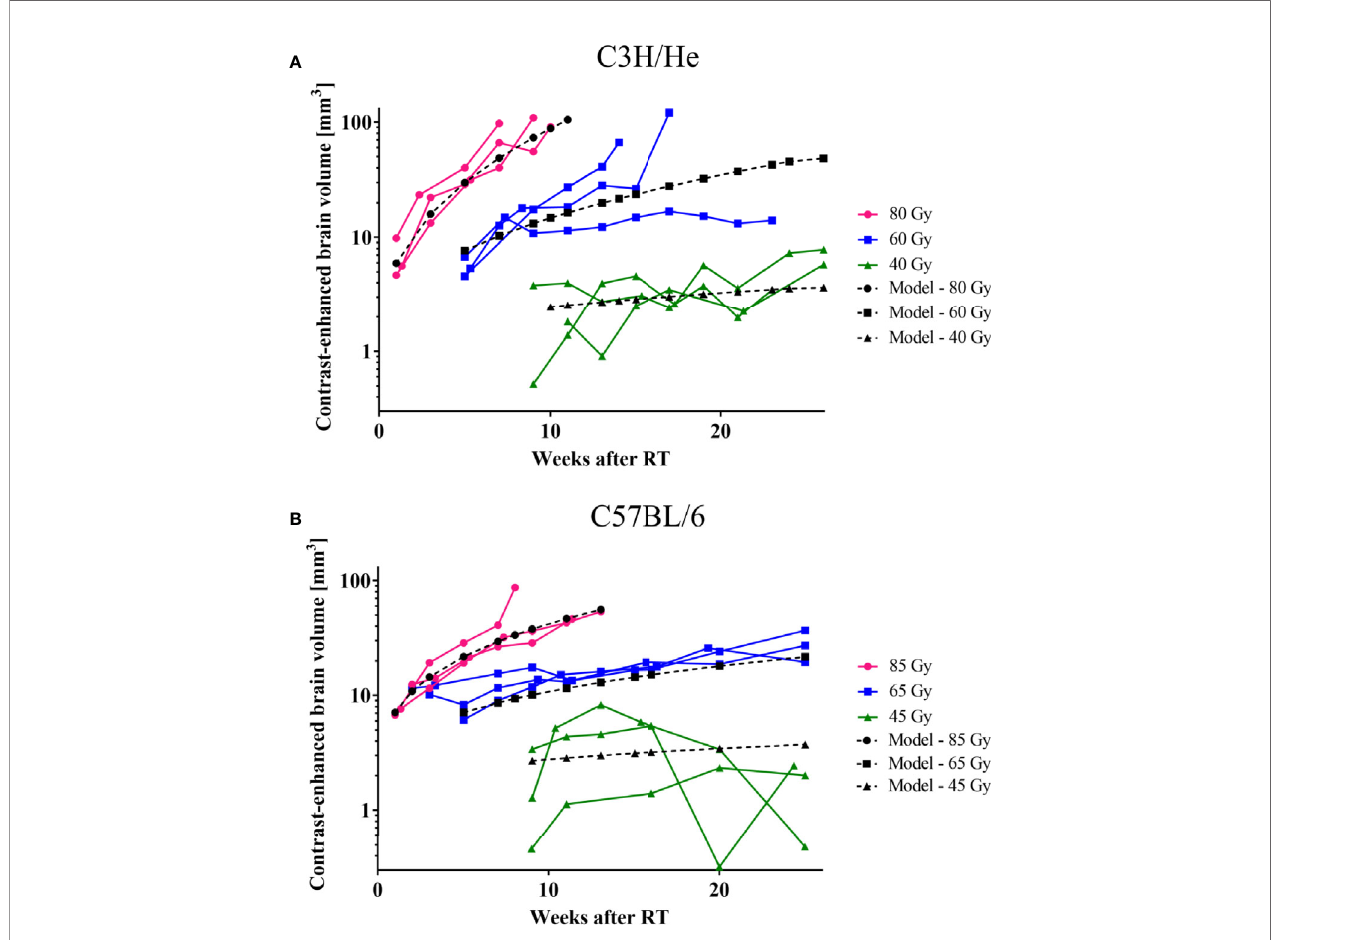
FIGURE 6 | CE-volume increase in T1w MR images and the dose-volume response model (black curves) derived from experimental data for (A) C3H and (B) C57BL/6 mice. Onset and progression were earlier and faster for higher doses. C57BL/6 progressed at a lower rate than C3H/He